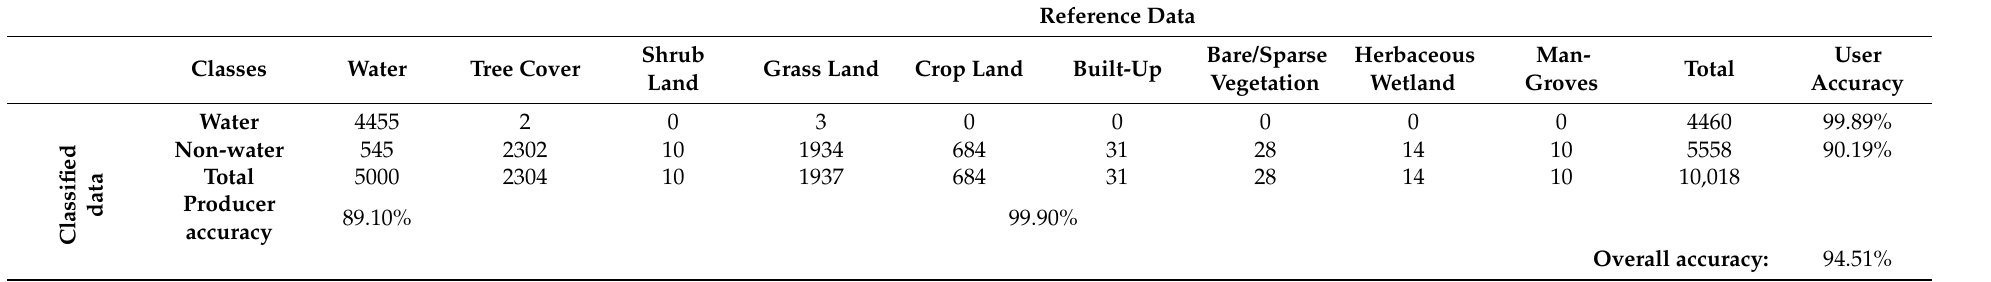
Table 7. Accuracy assessment results for CATWIC with slope, urban, and snow masks.